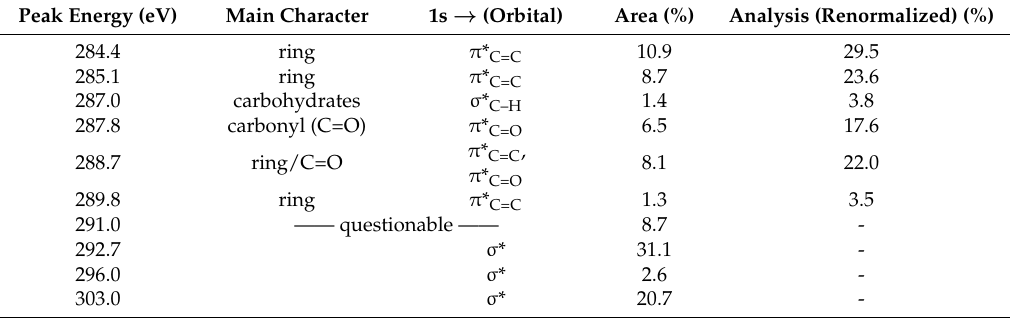
Figure 5. A NEXAFS spectrum of a 1 μm thick PET foil in the vicinity of carbon edge, obtained with one SXR pulse. Measured data points are indicated with circles, thick solid line depicts the fitting. Each contribution to the fitting is depicted by a thin solid line. A combined approach [9] was used, in which for each peak a separate 10% step function was employed. From the peaks composition of the PET sample was subsequently calculated. Table 1. Energy positions and assignments of features depicted in Figure 5, taken from [27], in the C-1s NEXAFS spectrum of PET foil, based on synchrotron